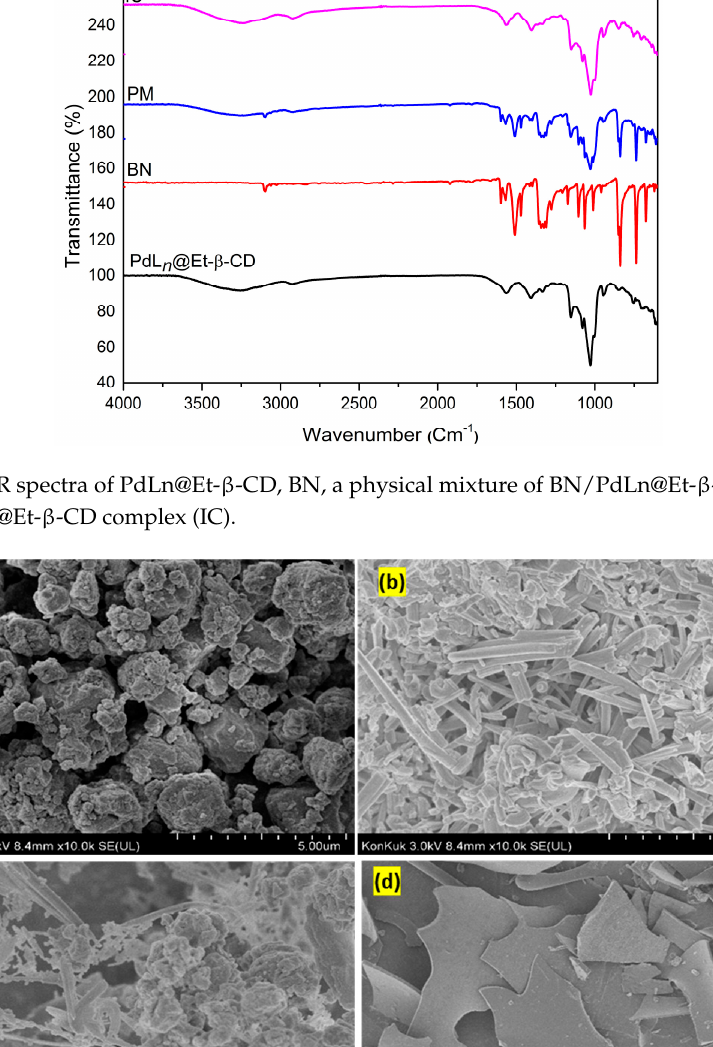
Figure. 7. FT ‐ IR spectra of PdLn@Et ‐β‐ CD, BN, a physical mixture of BN/PdLn@Et ‐β‐ CD (PM), and the BN/PdLn@Et ‐β‐ CD complex (IC).